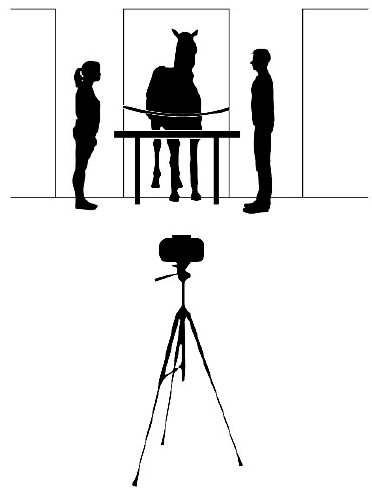
Figure 1. The experimental setting of the no food condition (NF), solvable (SC), and impossible (IC) conditions. The apparatus consisted of a table (85 × 85 cm), placed close to the entrance of the stall, which was freely accessible by horses. The caretaker was positioned to the left of the horse, while the unknown person was positioned on the right. A rope was placed across the stable door. The camera was located at a distance of 4 m in front of the horse.